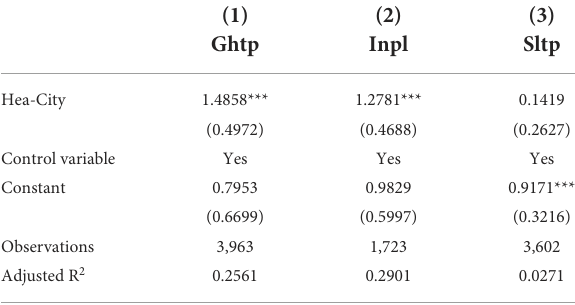
TABLE 6 Mechanism for healthy city implementation to increase the amount of MSW collected.